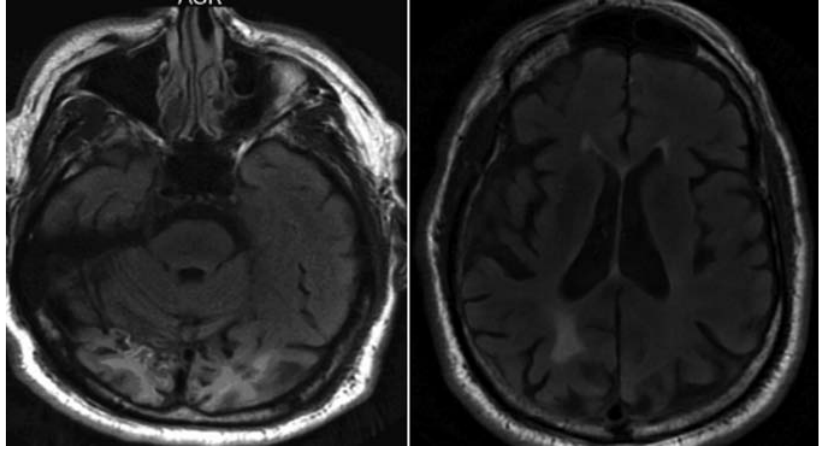
Figure 1. MRI Brain T-2 FLAIR sequence showing the bilateral occipital infarcts.